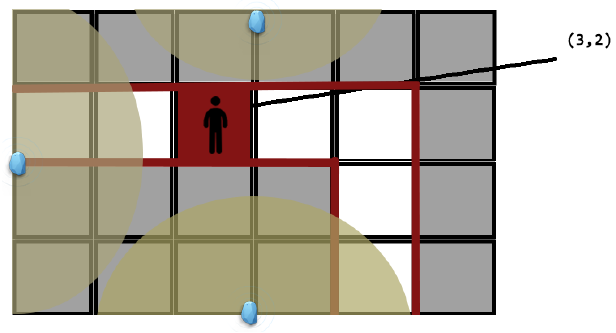
Figure 10. Beacons detecting current indoor BVI user position.